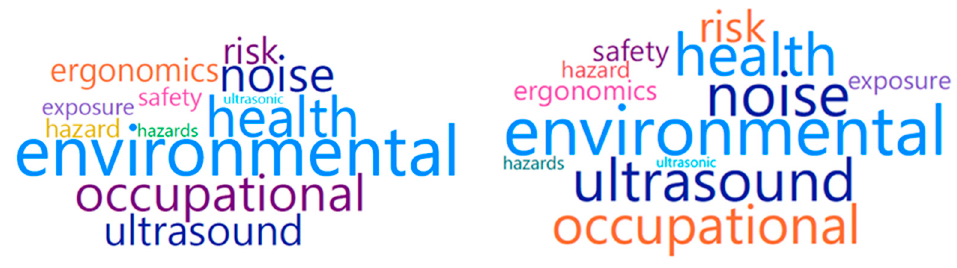
Figure 1. Keywords for issues related to the effect of ultrasound on environmental and occupational health in the period of 1900–2000 ( Left ) and in the last 5 years ( Right ).